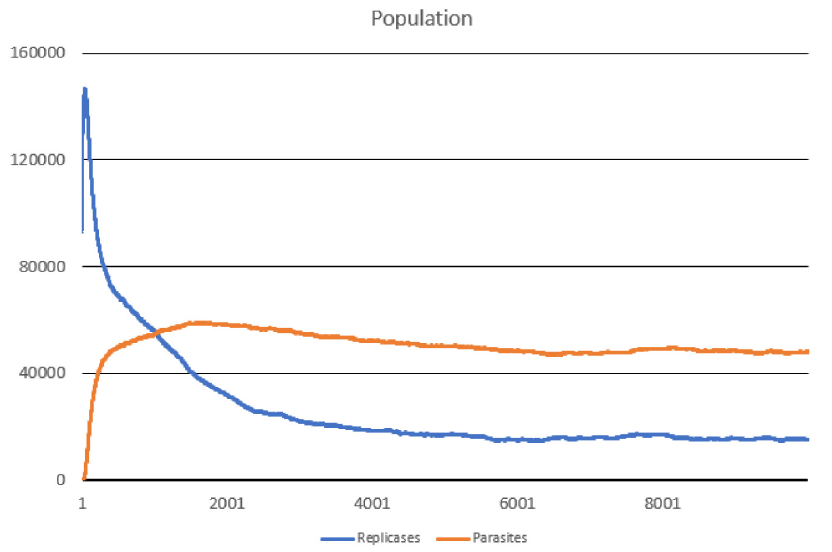
Fig 8. Population of parasites and replicases in Scenario 3.